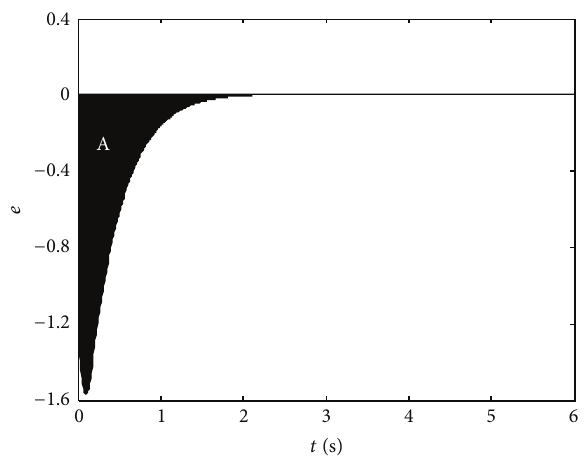
Figure 6: Curve of tracking error (controller C).